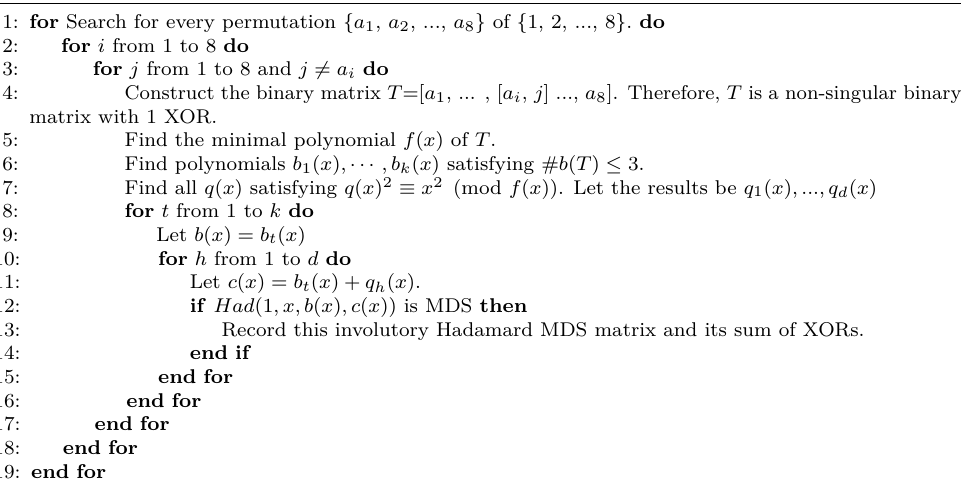
Algorithm 2 Construction of lightweight involutory Hadamard MDS